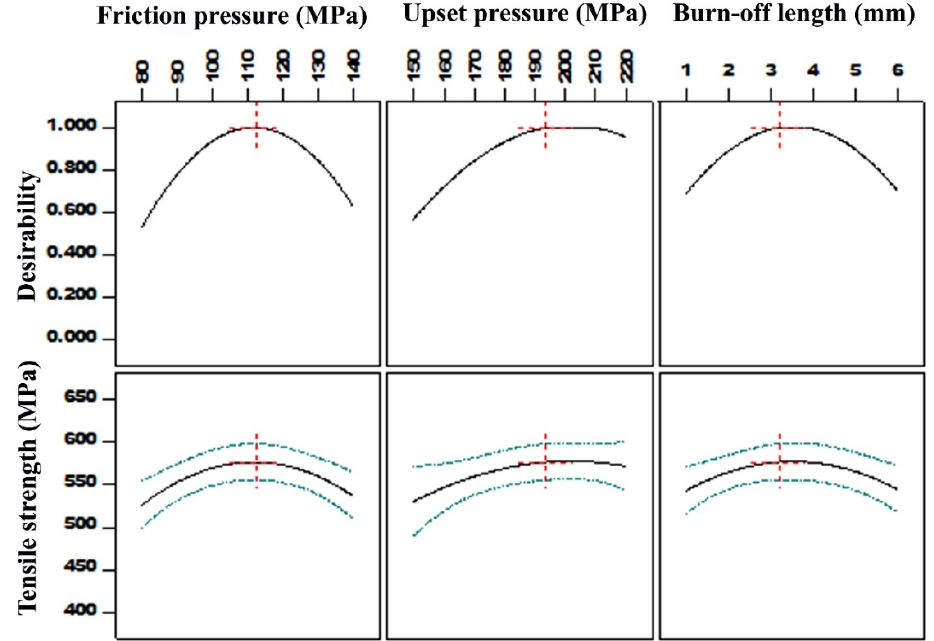
Figure 3. The individual effects of input factors on the tensile strength and desirability.